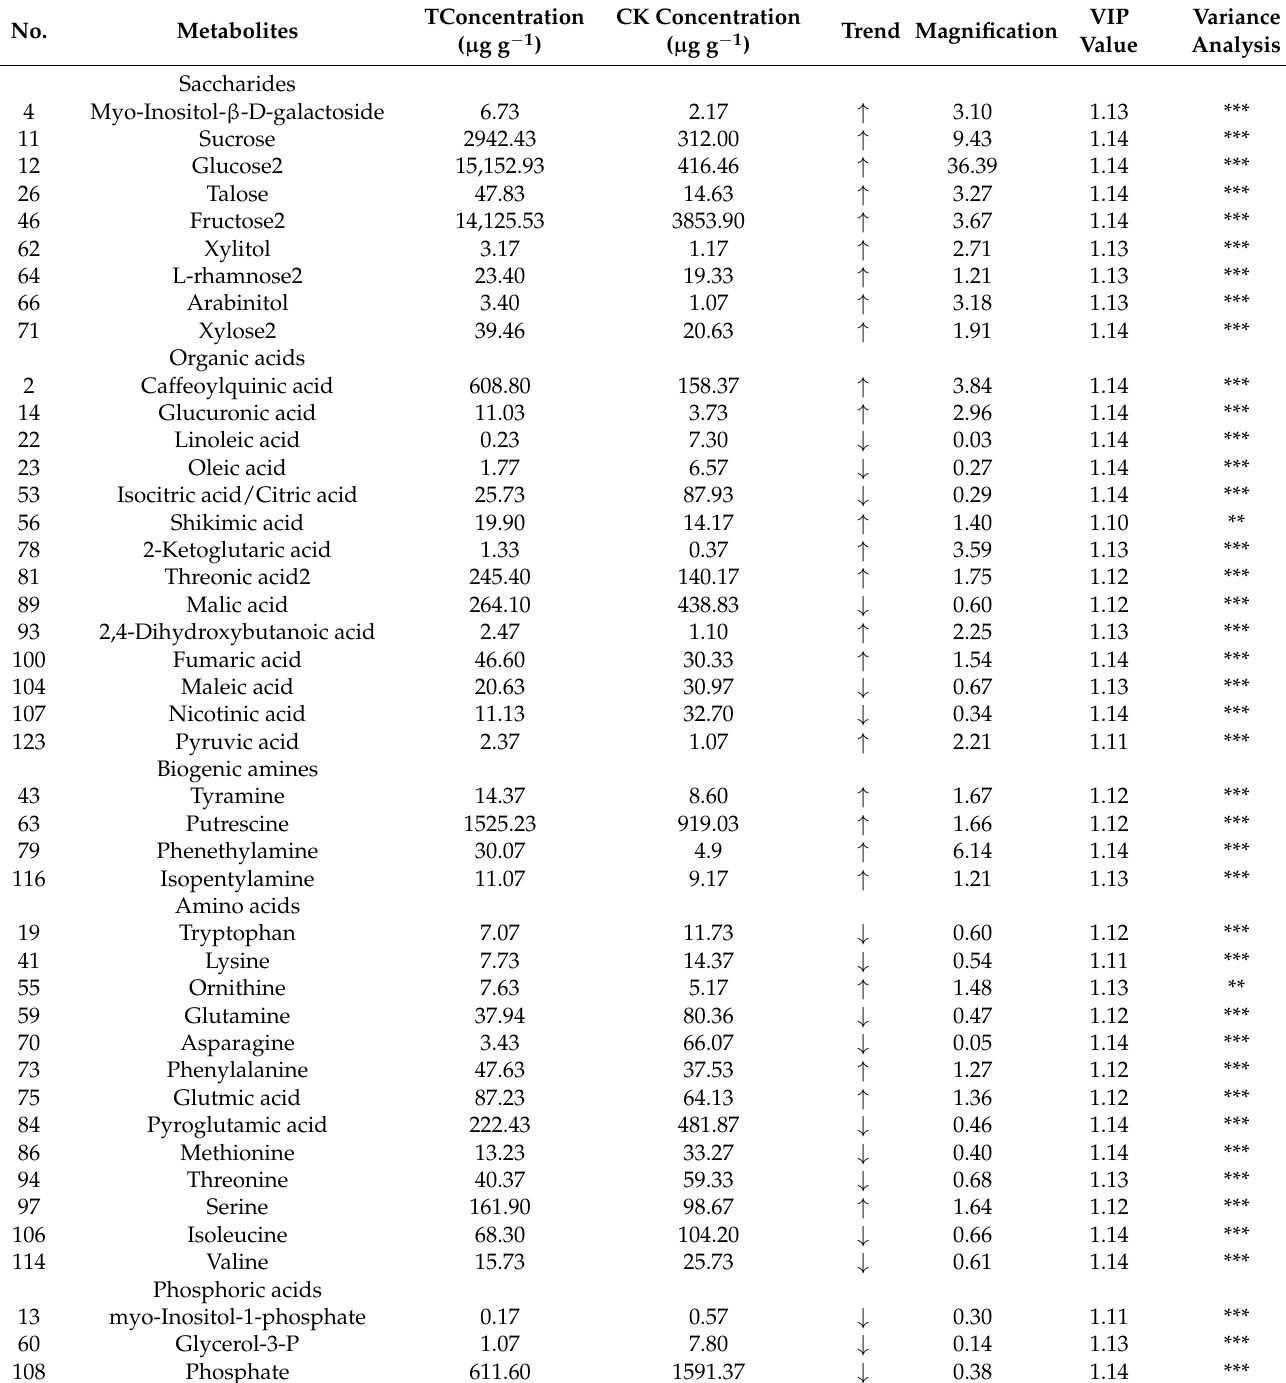
Table 2. Analysis of differential metabolites in tobacco